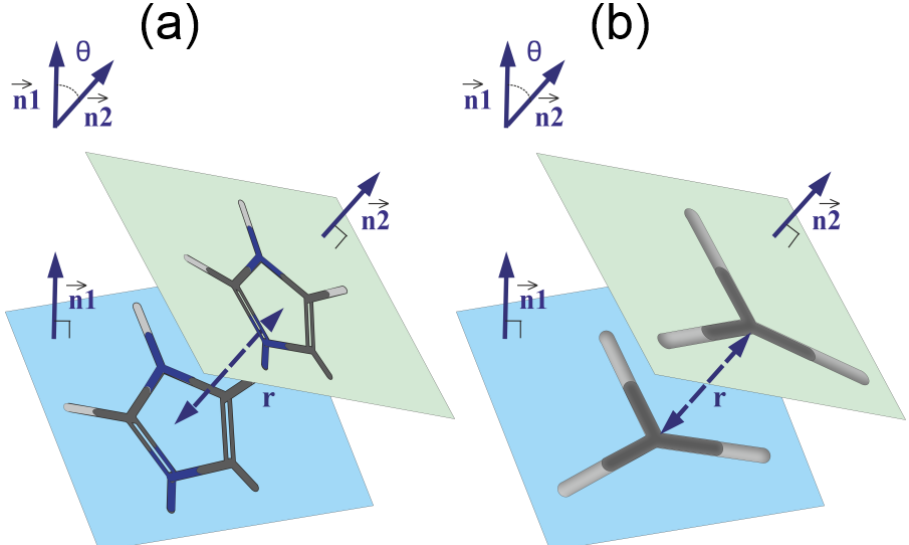
Figure 9. The schematic model of pairing of ( a ) imidazole–imidazole groups and ( b ) guanidine– guanidine groups. The geometrical parameters of the pairs: the distance r between the centers of the groups, the normal vectors (cid:126) n 1 and (cid:126) n 2 to the planes of the groups and the angle θ between these vectors are